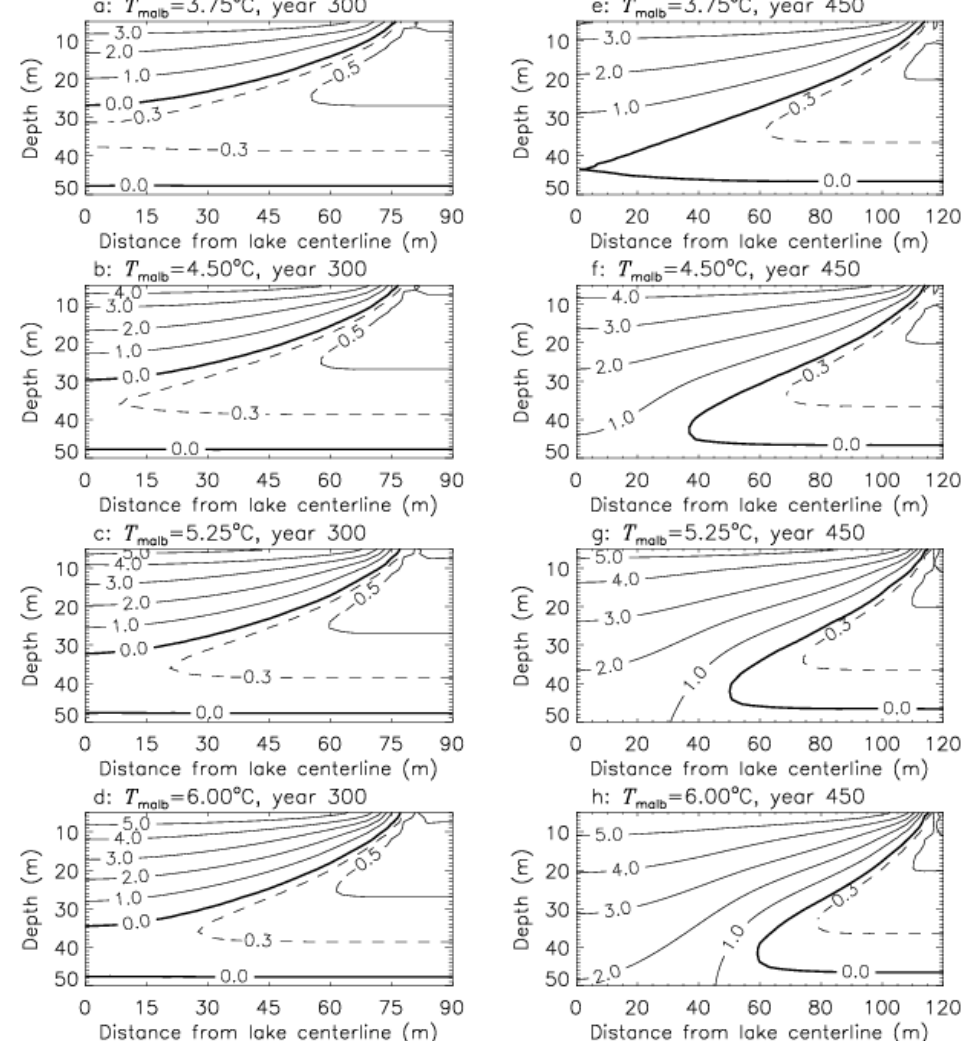
Figure 4. Simulated ground thermal regimens and talik thicknesses beneath the expanding thermokarst lakes with different mean annual lake bottom temperatures on the last days of year 300 ( a – d ) and year 450 ( e – h ) after the thermokarst lakes’ formation.